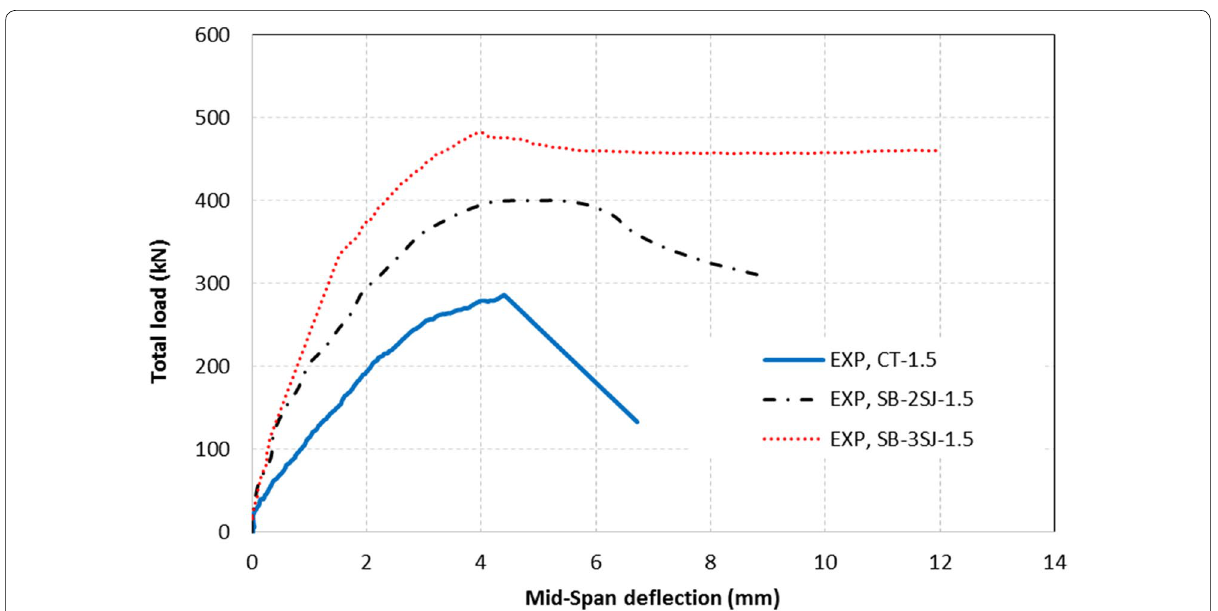
Fig. 13 Load – deflection curves of all beams with a / d